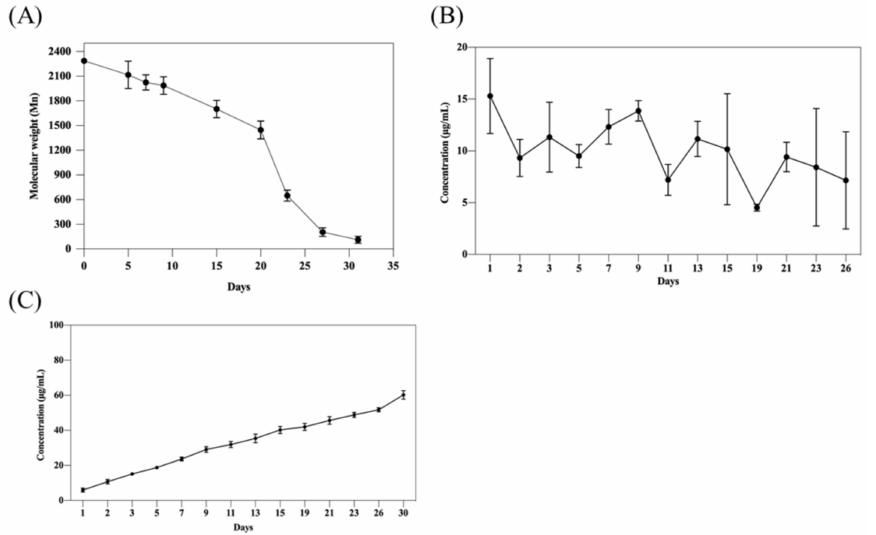
Figure 4. In vitro testing of mPEG-PLCL/0.5% PVP for ( A ) degradation. ( B ) Daily measurements of tacrolimus release. ( C ) Accumulated amount of tacrolimus release.